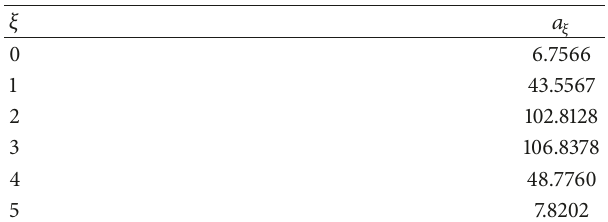
Table 1: Values of coefficients 𝑎 𝜉 for (14). Table 2: ANOVA for the modelled correlation in